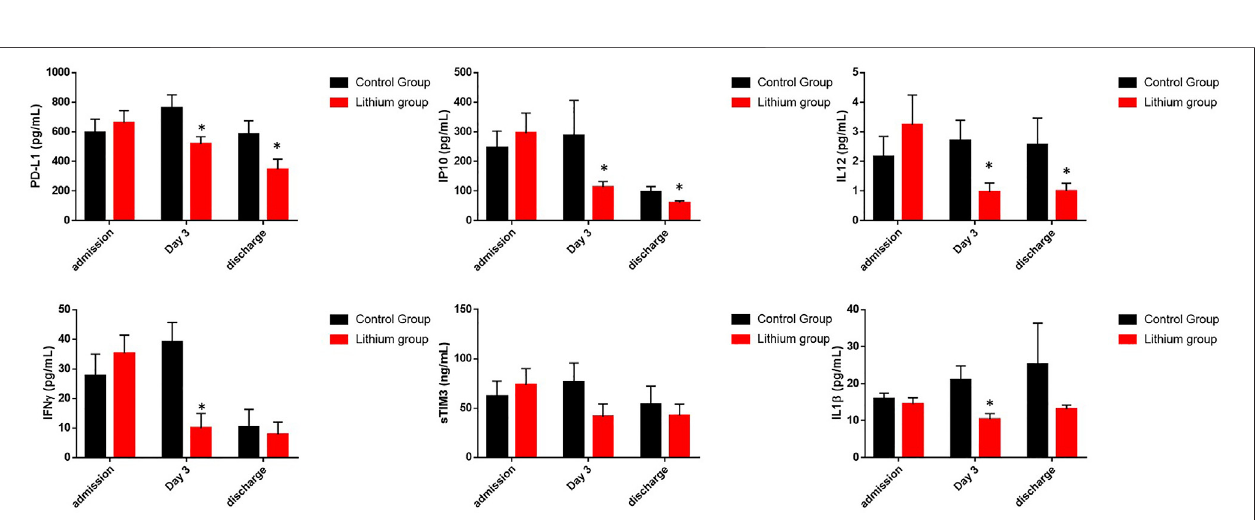
FIGURE 5 | Representation of cytokine levels involved in acute in fl ammation measured during admission, after 3 days with treatment and during discharge. The graphsrepresenttheareaunderthecurveofcytokinelevelsmeasuredduringthestudy.* p < 0.05and** p < 0.01.Itcanbeseenhowlithiumtreatmentreducesthelevels of acute in fl ammation after 3 days of treatment compared to the control